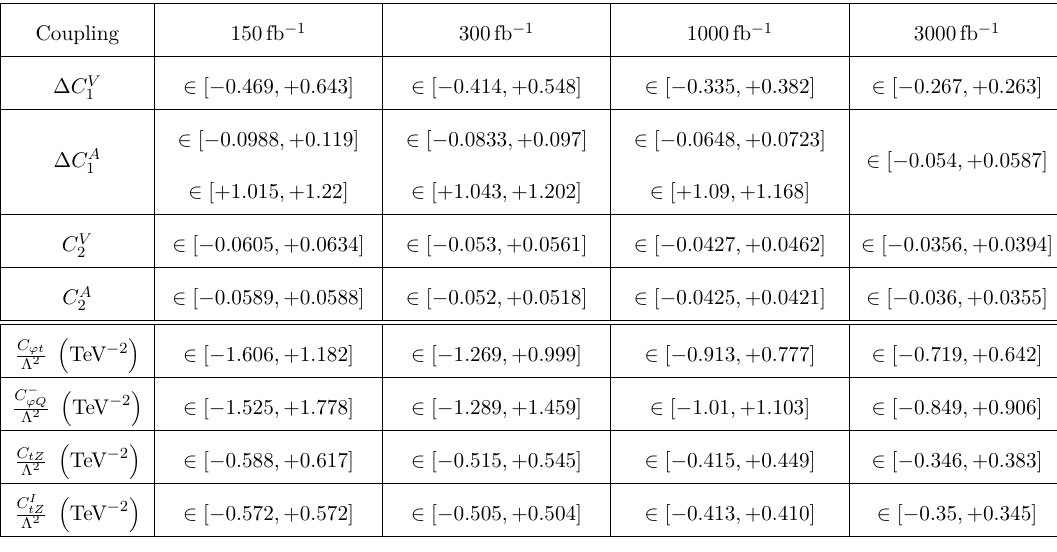
Table 2 . One parameter 95% C.L. limits on the couplings projected in the t ¯ tZ : 4 l +3 l +2 l channel